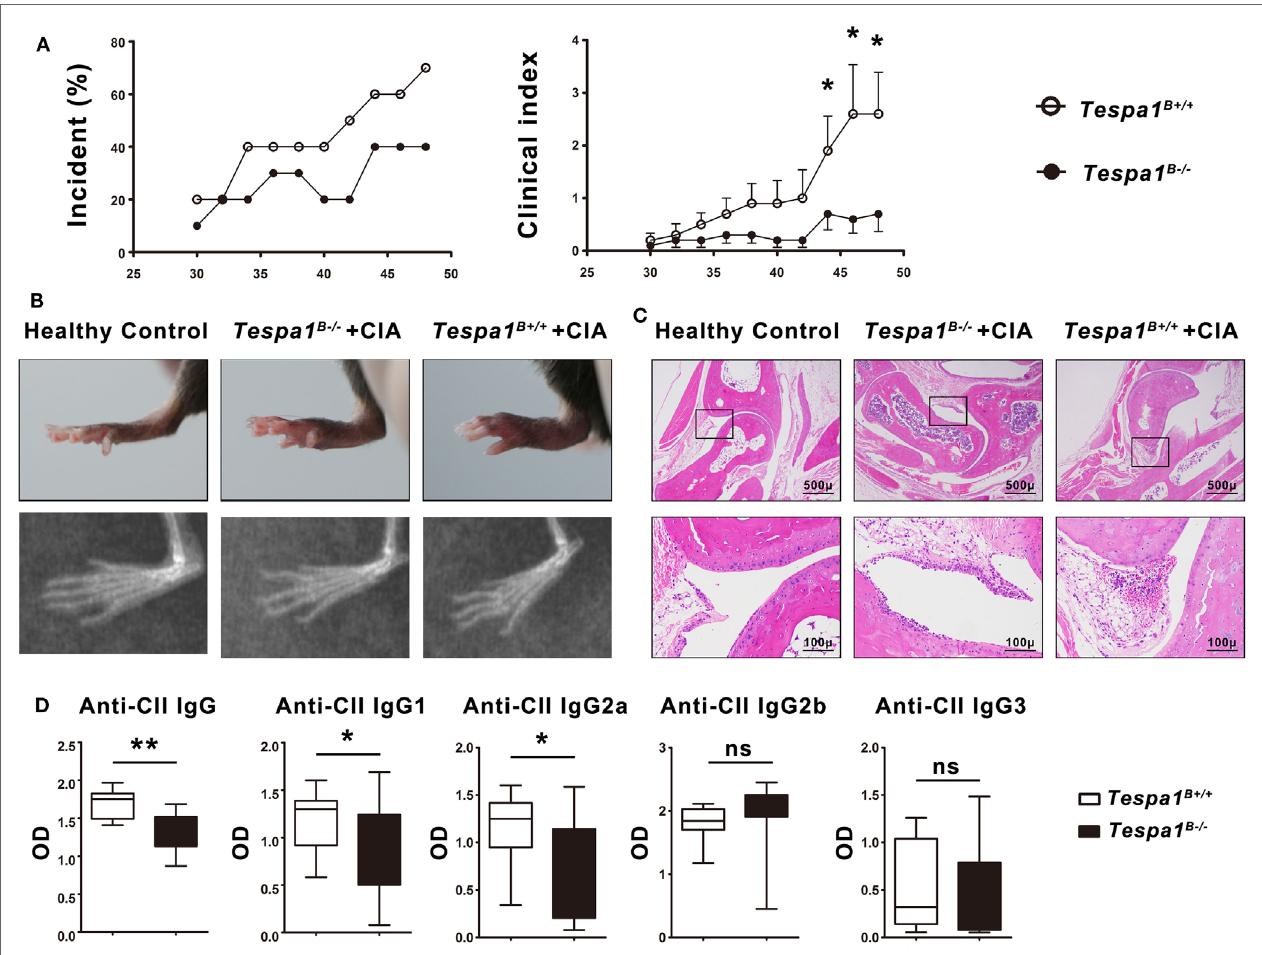
FigUre 6 | Tespa1 deficiency significantly attenuates collagen-induced arthritis (CIA) in chimeric mice. (a) Incidence and clinical arthritis scores of Tespa1 -deficient and WT chimeras following experimental induction of CIA. (B) Photographs and X-ray images of the hind limbs of WT and Tespa1 -deficient chimeras 6 weeks after the first CII injection. (c) Microscopic sections of the knee joints of Tespa1 -deficient and WT chimeras stained with H&E. Images are shown at 10 × and 50 × magnification. (D) Anti-collagen II IgG, IgG1, IgG2a, IgG2b, and IgG3 antibody levels in the sera of WT and Tespa1 -deficient chimeras following CIA induction. Data shown are the mean ± SEM with 10 mice per group and are from one experiment, representative of two performed. * p < 0.05 and ** p < 0.01 (Mann–Whitney